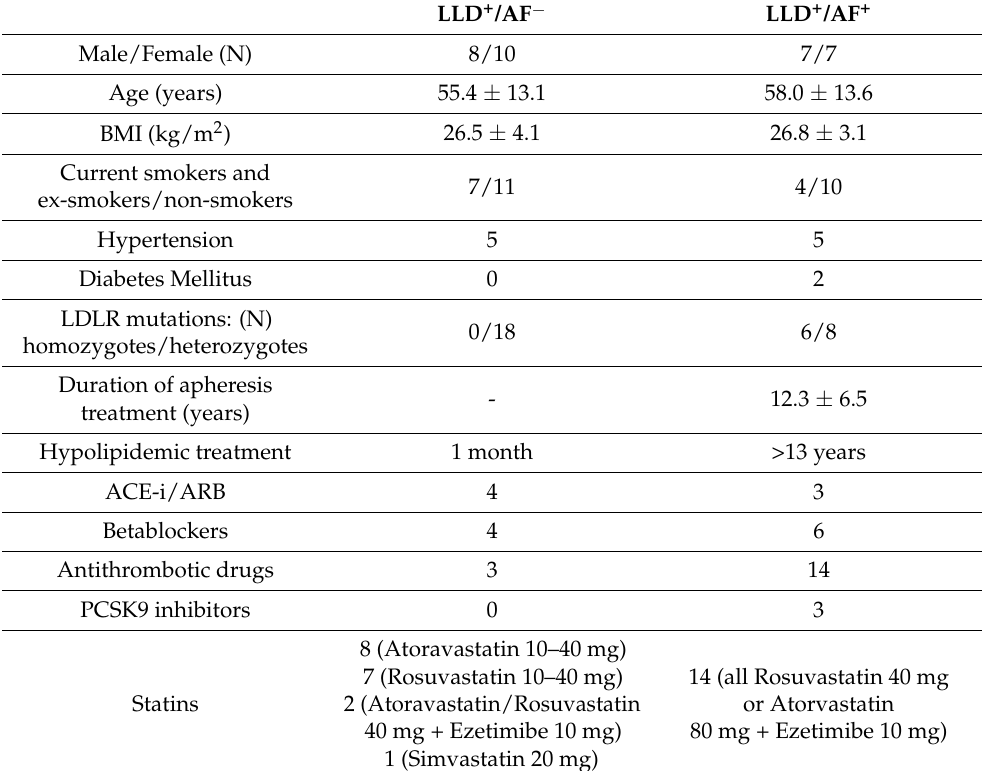
Table 1. Basic characteristics of